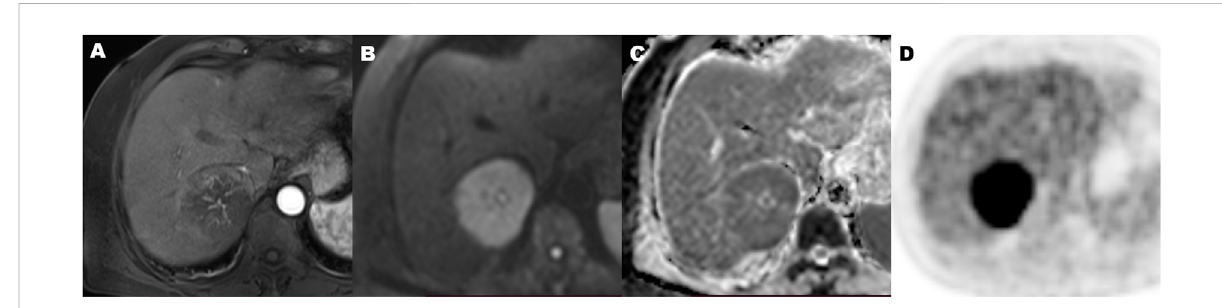
FIGURE 5 A 70-year-old hepatocellular carcinoma in liver segment VII woman with microvascular invasion, demonstrating Hypovascular enhancement pattern, high metabolic of SUVmax 9.2, MTV 134.2 cm 3 , TLG 915.2, TLR 4.5, and ADC of 0.86 × 10 − 3 mm 2 /s. Contrast-enhanced MR in arterial phase image (A) ,diffusion-weightedMRimage (B) ,ADCmap (C) ,and 18 F-FDGPET (D) (MTV,metabolictumorvolume;TLG,totallesionglycolysis;TLR,ratio of tumor-to-liver SUV; ADC, apparent diffusion coef fi cient).